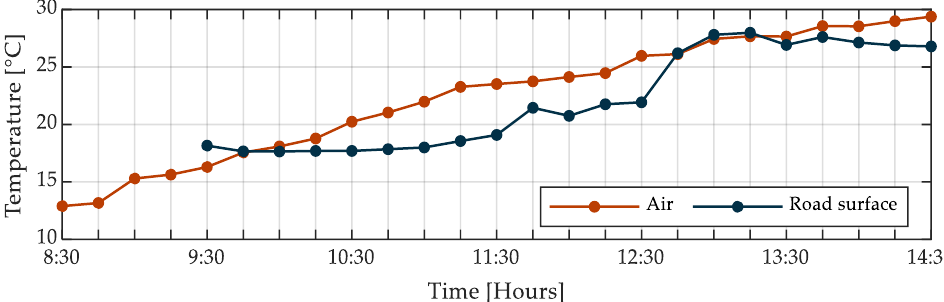
Figure 14. Air and road surface temperature variations during the proof test procedures.